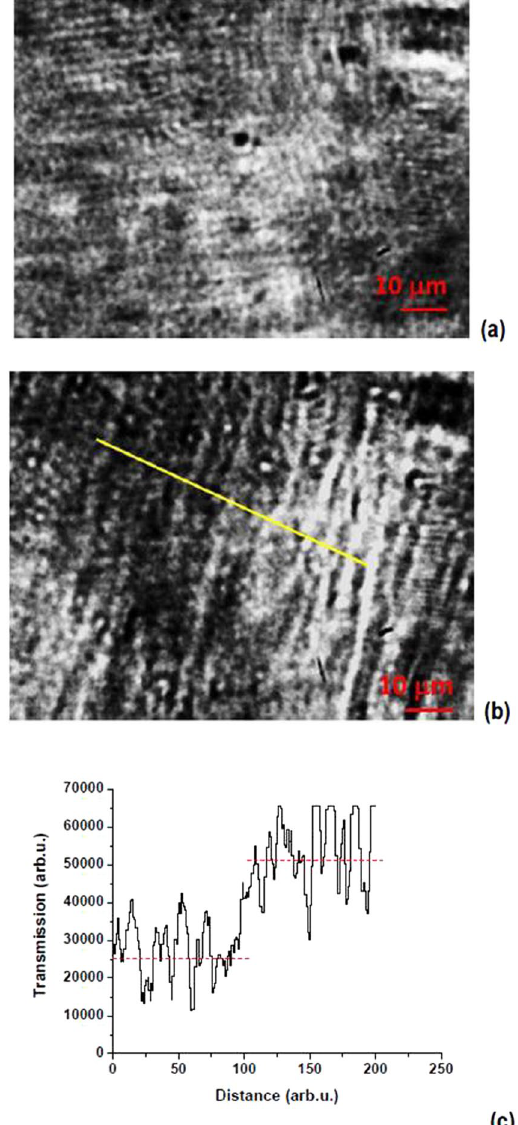
Figure 6. ( a , b ) Microscopic images of the ferrofluid in external magnetic field observed in transmission mode at 1550 nm exhibit considerable contrast between different Minkowski domains. ( c ) Cross section of microscopic image ( b ) along the yellow line shows more than two fold variation in Minkowski domain transmission, which indicates more than two fold variation in radiation lifetime of the excited states of fatty acid molecules in these